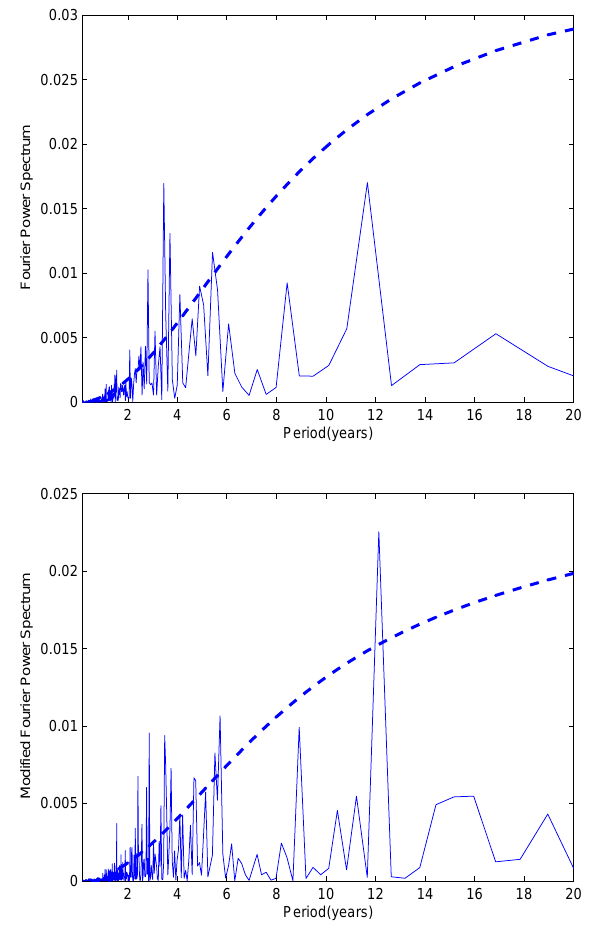
Fig. 5. (Top) Fourier power spectrum of Nino3.4 indices is com- Figure 5: (Top) Fourier power spectrum of Nino3.4 indices is computed by discrete Fourier transform. (Bottom) puted by discrete Fourier transform. (Bottom) Modified Fourier Modified Fourier power spectrum of Nino3.4 indices is computed by our method. The dashed line is 95% power spectrum of Nino3.4 indices is computed by our method. The confidence red noise spectrum . dashed line is 95% confidence red noise spectrum